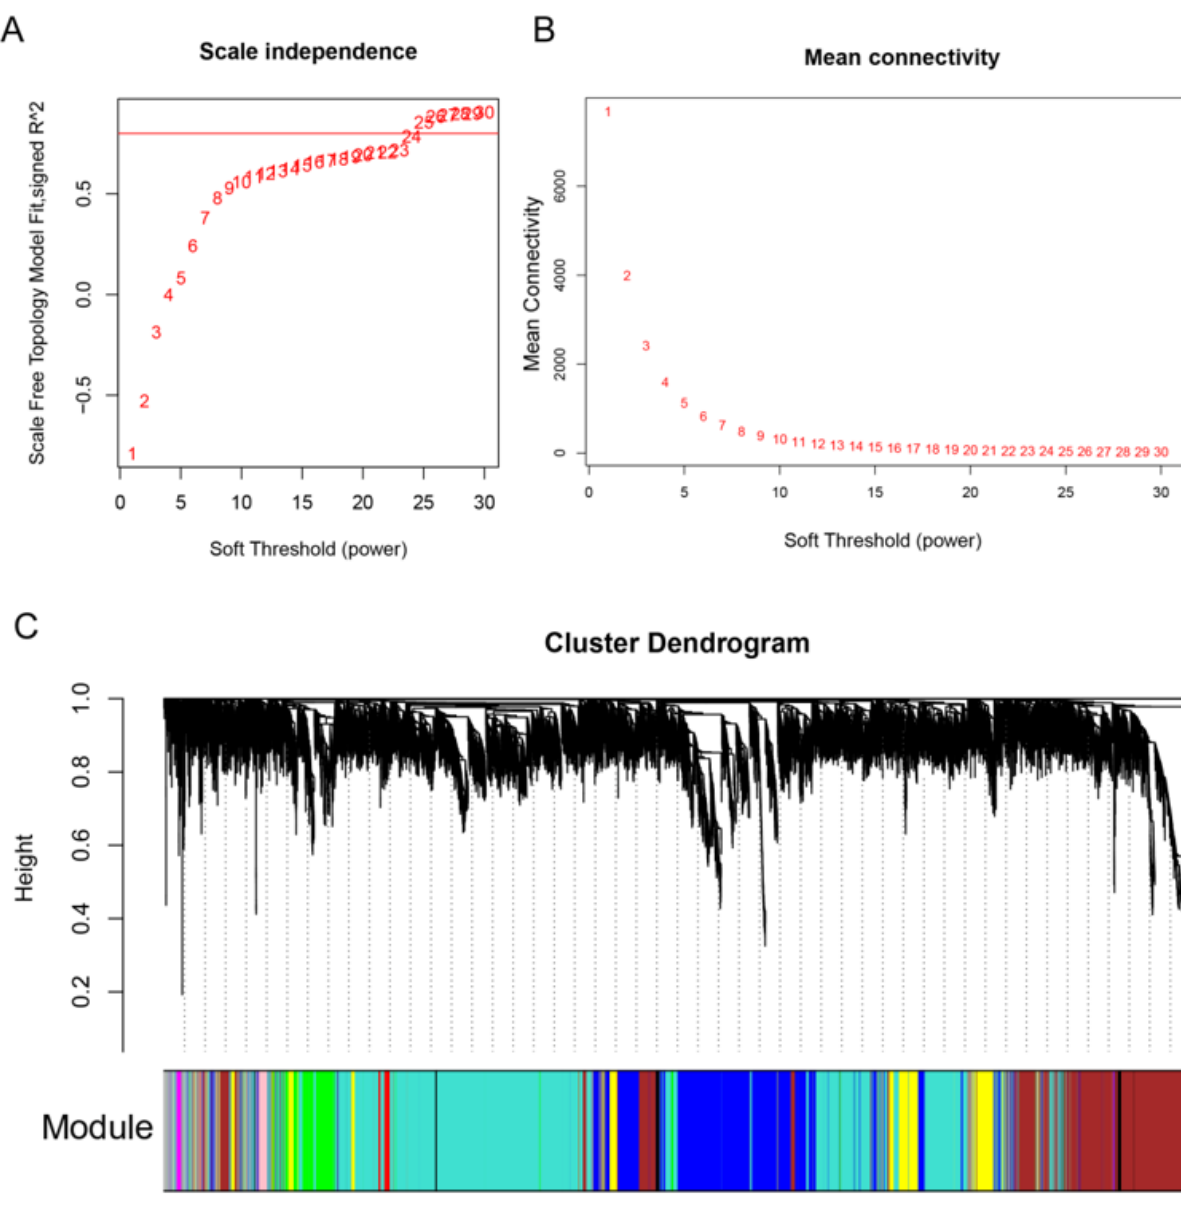
Figure 4. Module identification by weighted gene co-expression network analysis (WGCNA). ( A , B ) represent the soft threshold with scale independence and mean connectivity. ( C ), Hierarchical dendrogram reveals co-expression modules identified by WGCNA. Each leaf represents one gene. Ten modules were identified based on calculation of eigengenes; each module was decorated with a different color.